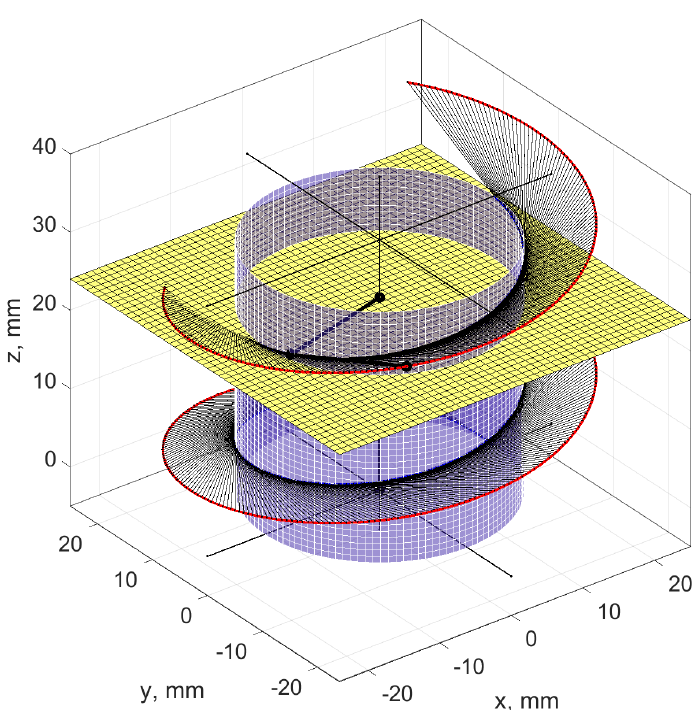
Figure 2. Involute helical